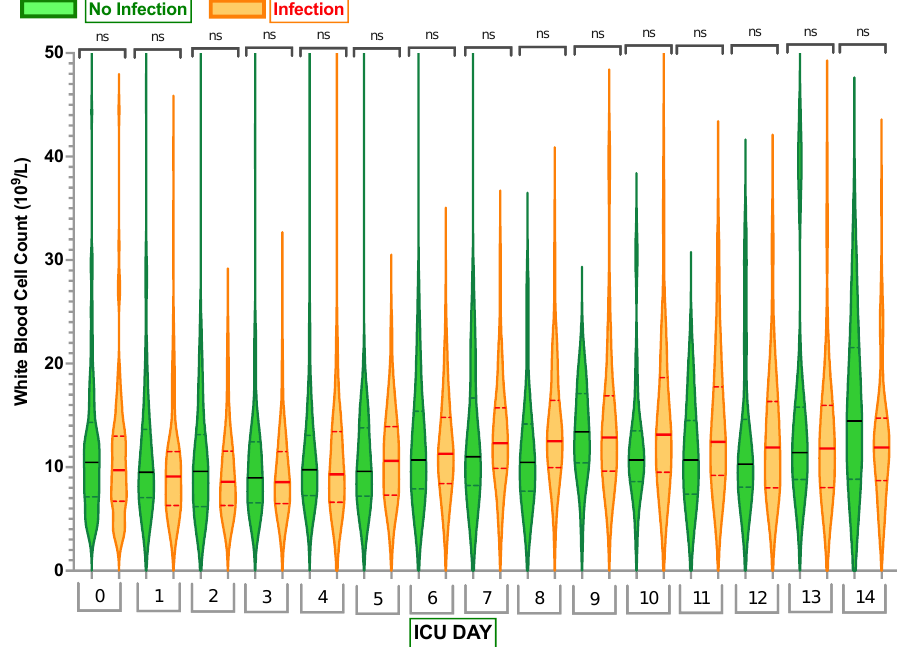
Figure 3. Comparison of white blood cell (WBC) count in the Infection Group and No Infection Group. Violin plots represent the distribution of data. Hard lines show medians, and dashed lines show interquartile ranges. The y-axis represents white blood cell count in 10 9 /L. The x-axis represents Days in the Intensive Care Unit (ICU) with 0—white blood cell count Day 0. ns—no statistically significant difference from the independent Mann–Whitney U test.